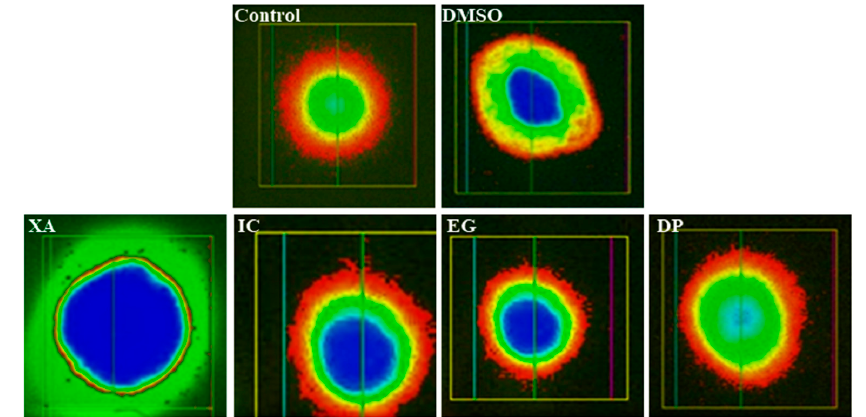
Figure 10. Comet assay: fluorescence micrographs of genotoxicity to Hela cells obtained after 24 h of the treatment of the four studied plant extracts XA, IC, EG and DP compared to untreated cells and vehicle (0.1 DMSO) treated cells. Table 1. Percentage of the head and tail of DNA after cell treatment with IC 50 of studied extracts.